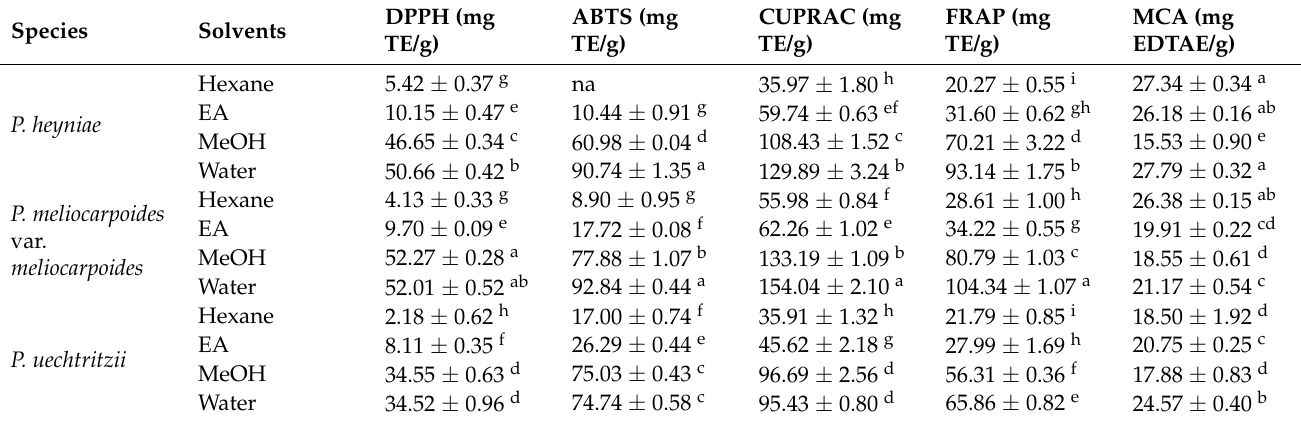
Table 3. Antioxidant properties of the tested extracts ( n =